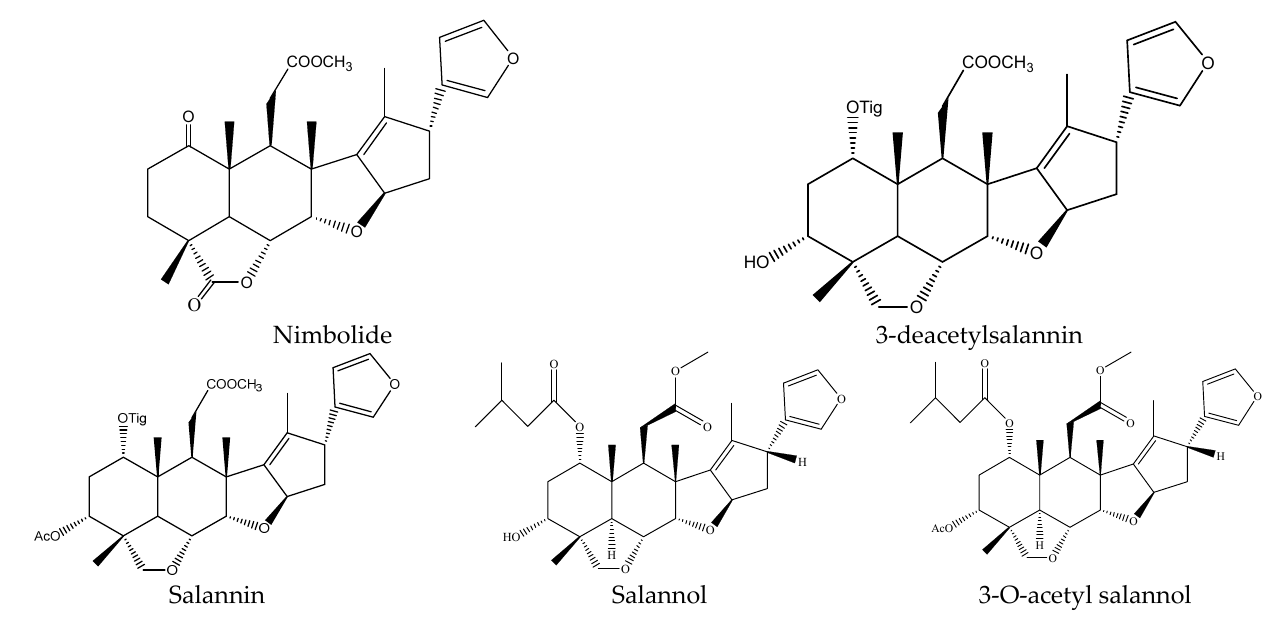
Figure 7. The structures of salannin-class chemicals.